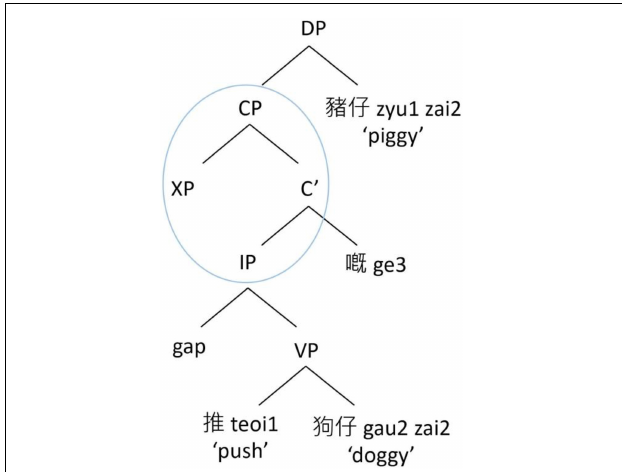
FIGURE 3 | Hierarchical structure of a Cantonese subject RC.